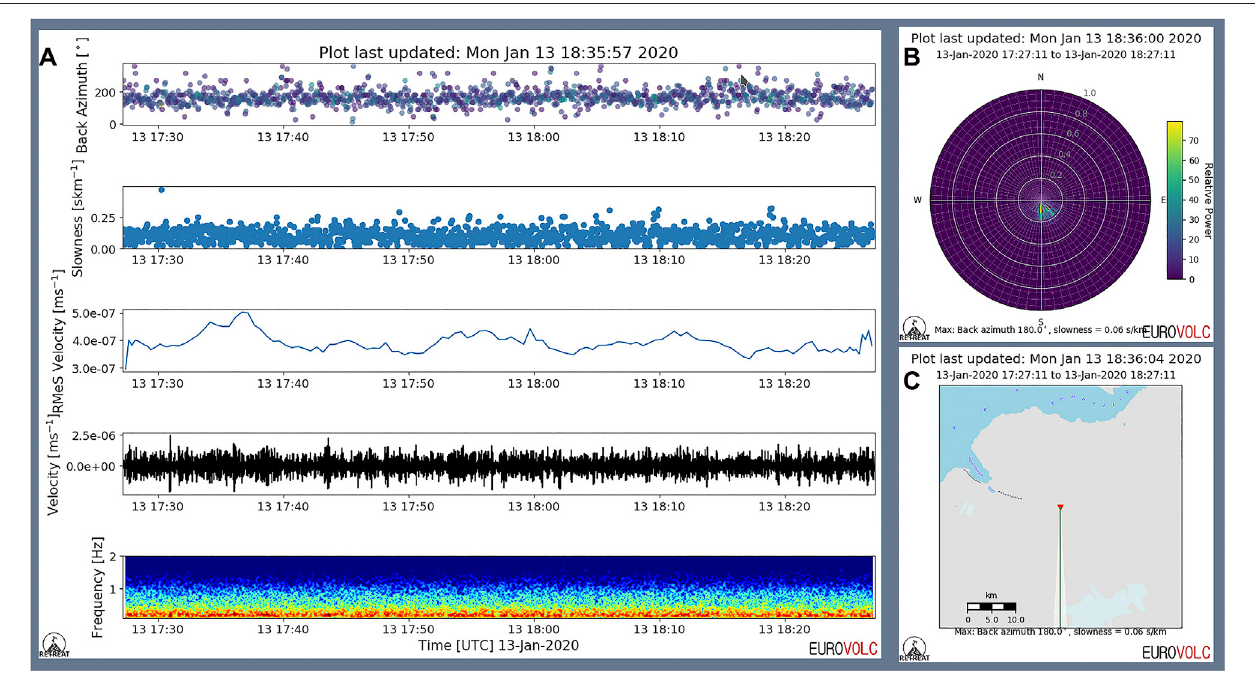
FIGURE 5 | Example of the output fi gures produced by the RETREAT software tool, showing (A) timeseries of the slowness and backazimuth calculated from the f-k analysis, alongside the seismic waveform, envelope and spectrogram and (B) a polar representation of the array processing results. Also shown is (C) a map of the area surrounding the SPITS array, with the resulting back azimuth overlaid. The azimuth error is illustrative only, determined from the resolution of the histogram. Implementation of uncertainty estimation for the back azimuth values is discussed further in Discussion .